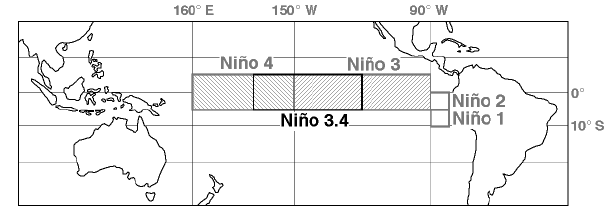
Fig. 5. SST regions (referred to Ni˜no1.2, Ni˜no3, Ni˜no4, and Ni˜no3.4) monitoring ENSO